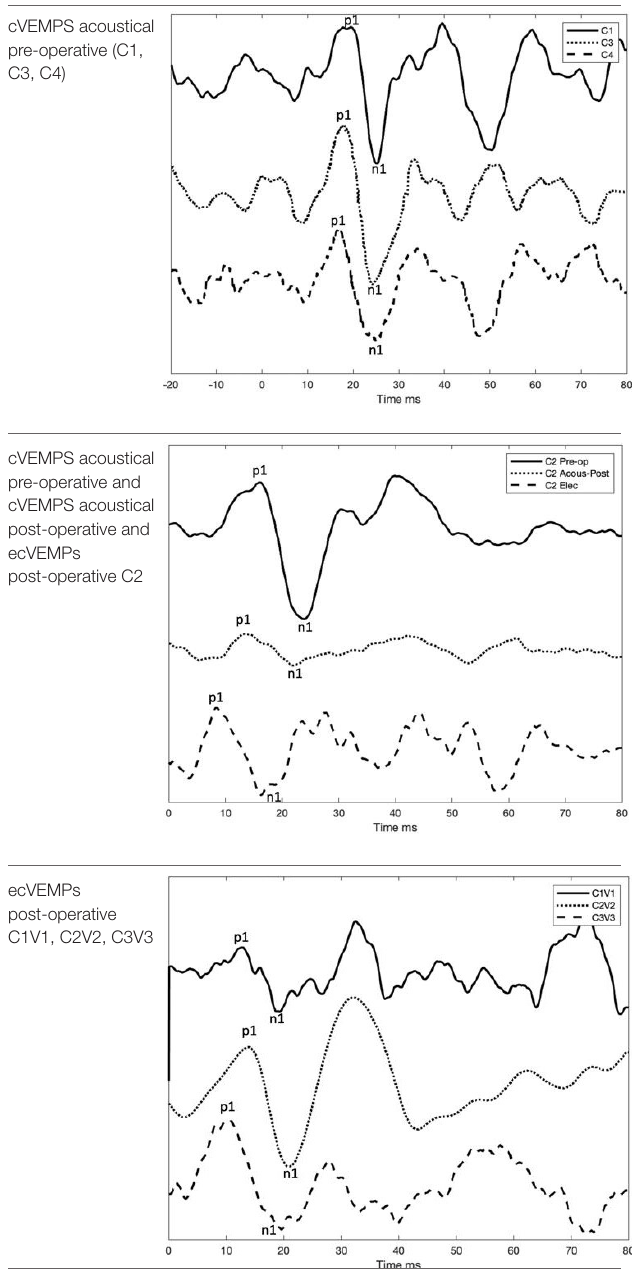
TABLE 5 | Waveforms of cervical VEMPs (cVEMPs) in response to acoustic (left) and electrical stimulation (right). cVEMPS acoustical pre-operative